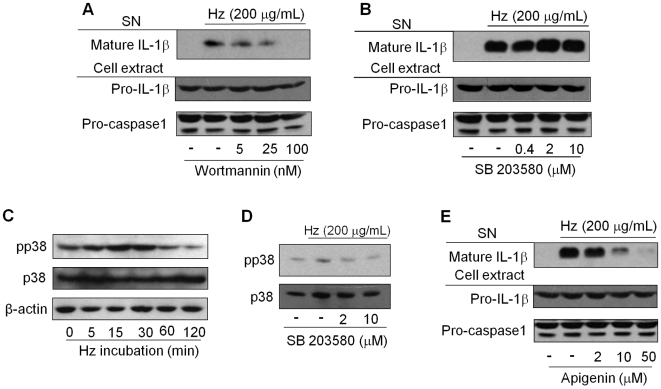
The role of other kinases in hemozoin-induced IL-1β.PMA-differentiated THP-1 cells (0.75×106 cells/0.5 mL) were pretreated with: (A) PI3K inhibitor – wortmannin, (B and D) p38 inhibitor - SB 203580, or (E) ERK inhibitor - apigenin followed by Hz (200 µg/mL) stimulation for six hours (IL-1β) or 30 minutes (pp38) or the indicated time (C). Supernatant (SN) and cell lysates were subjected to Western blot analysis with the indicated antibodies. Data show one experiment representative of two to five independent experiments.